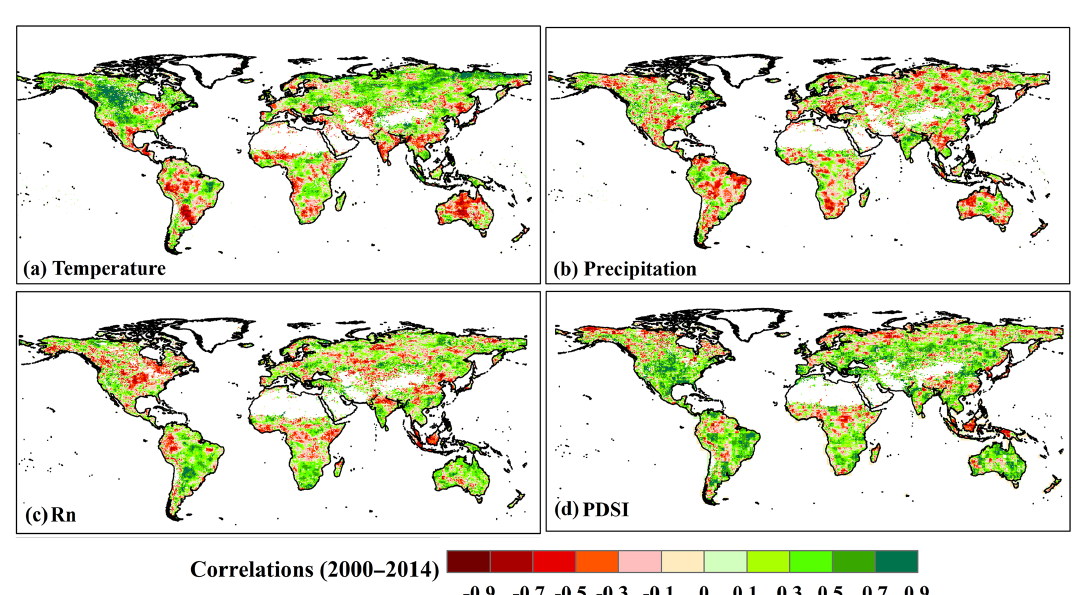
Figure 3. Partial correlations between NPP and (a) temperature, (b) precipitation, (c) net radiation, or (d) PDSI in growing